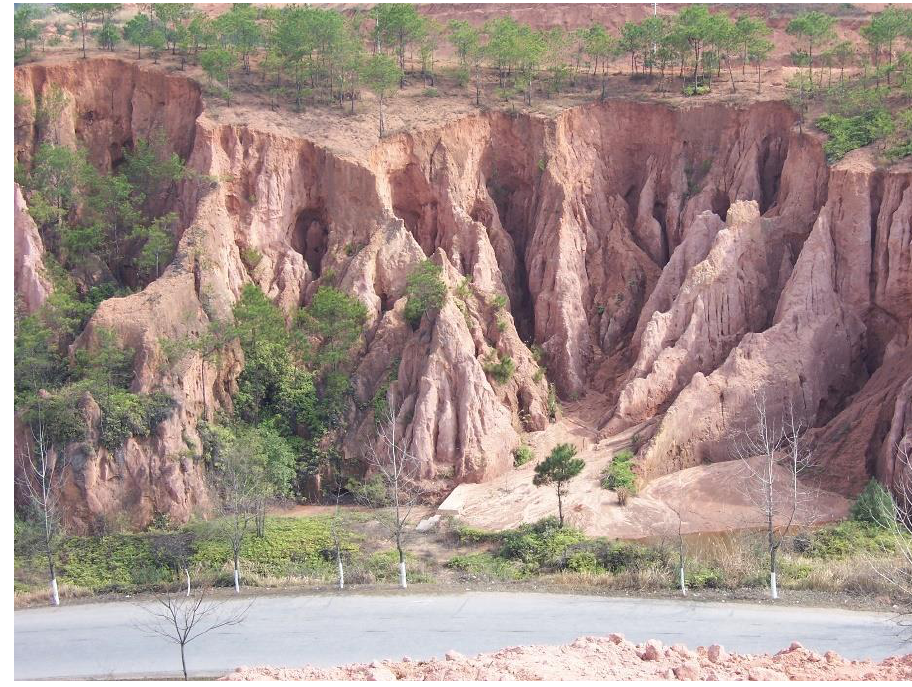
Figure 1. A typical Benggang